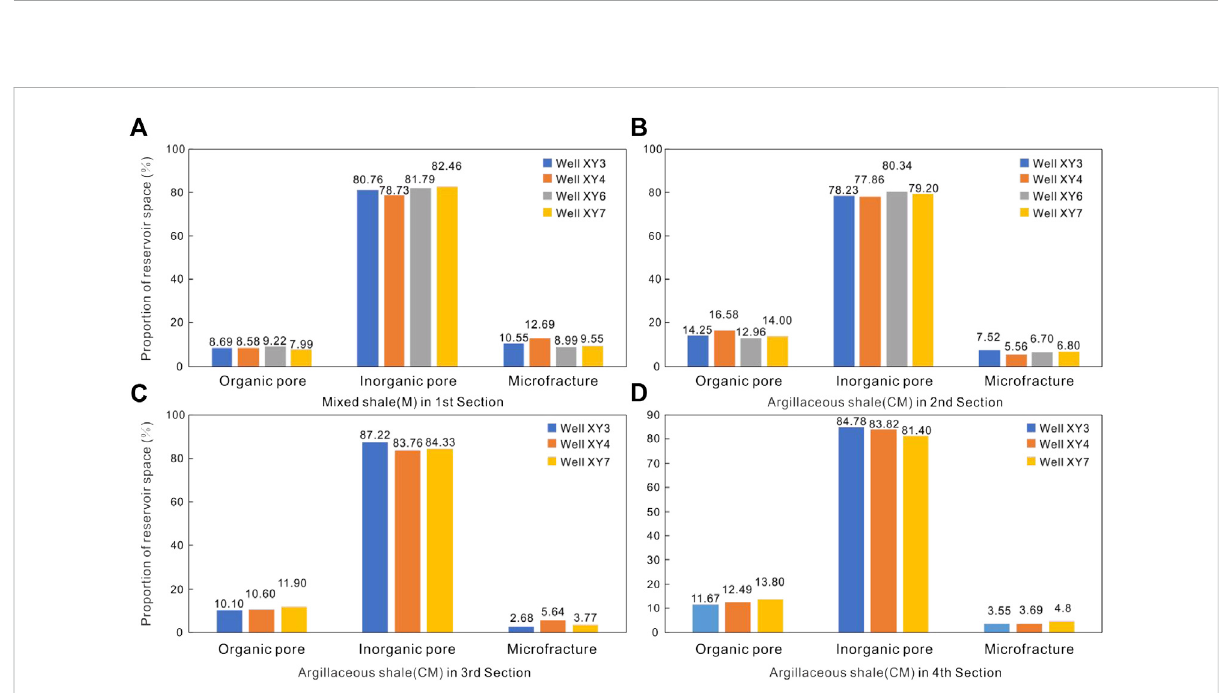
FIGURE 5 HistogramshowingproportionofreservoirspacesindifferentshalelithofaciesfortheJurassicDongyuemiaolacustrineshaleinEasternSichuan